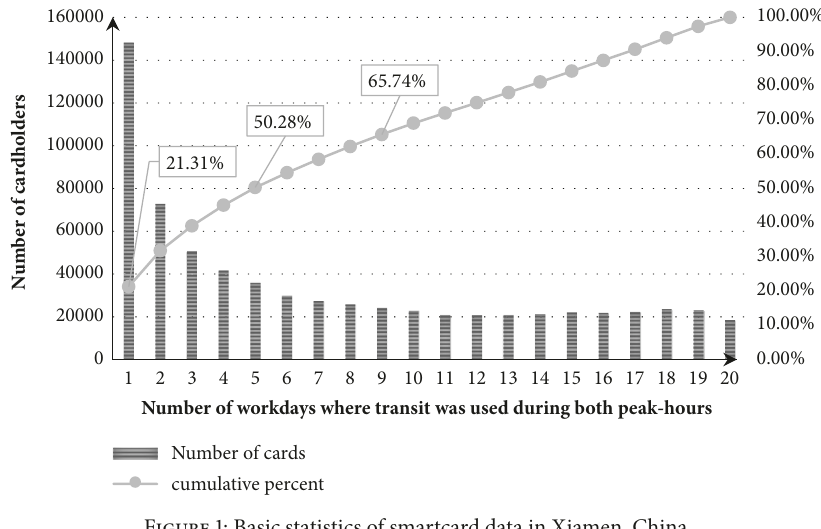
Figure 1: Basic statistics of smartcard data in Xiamen, China. Table 1: Examples of smartcard transaction